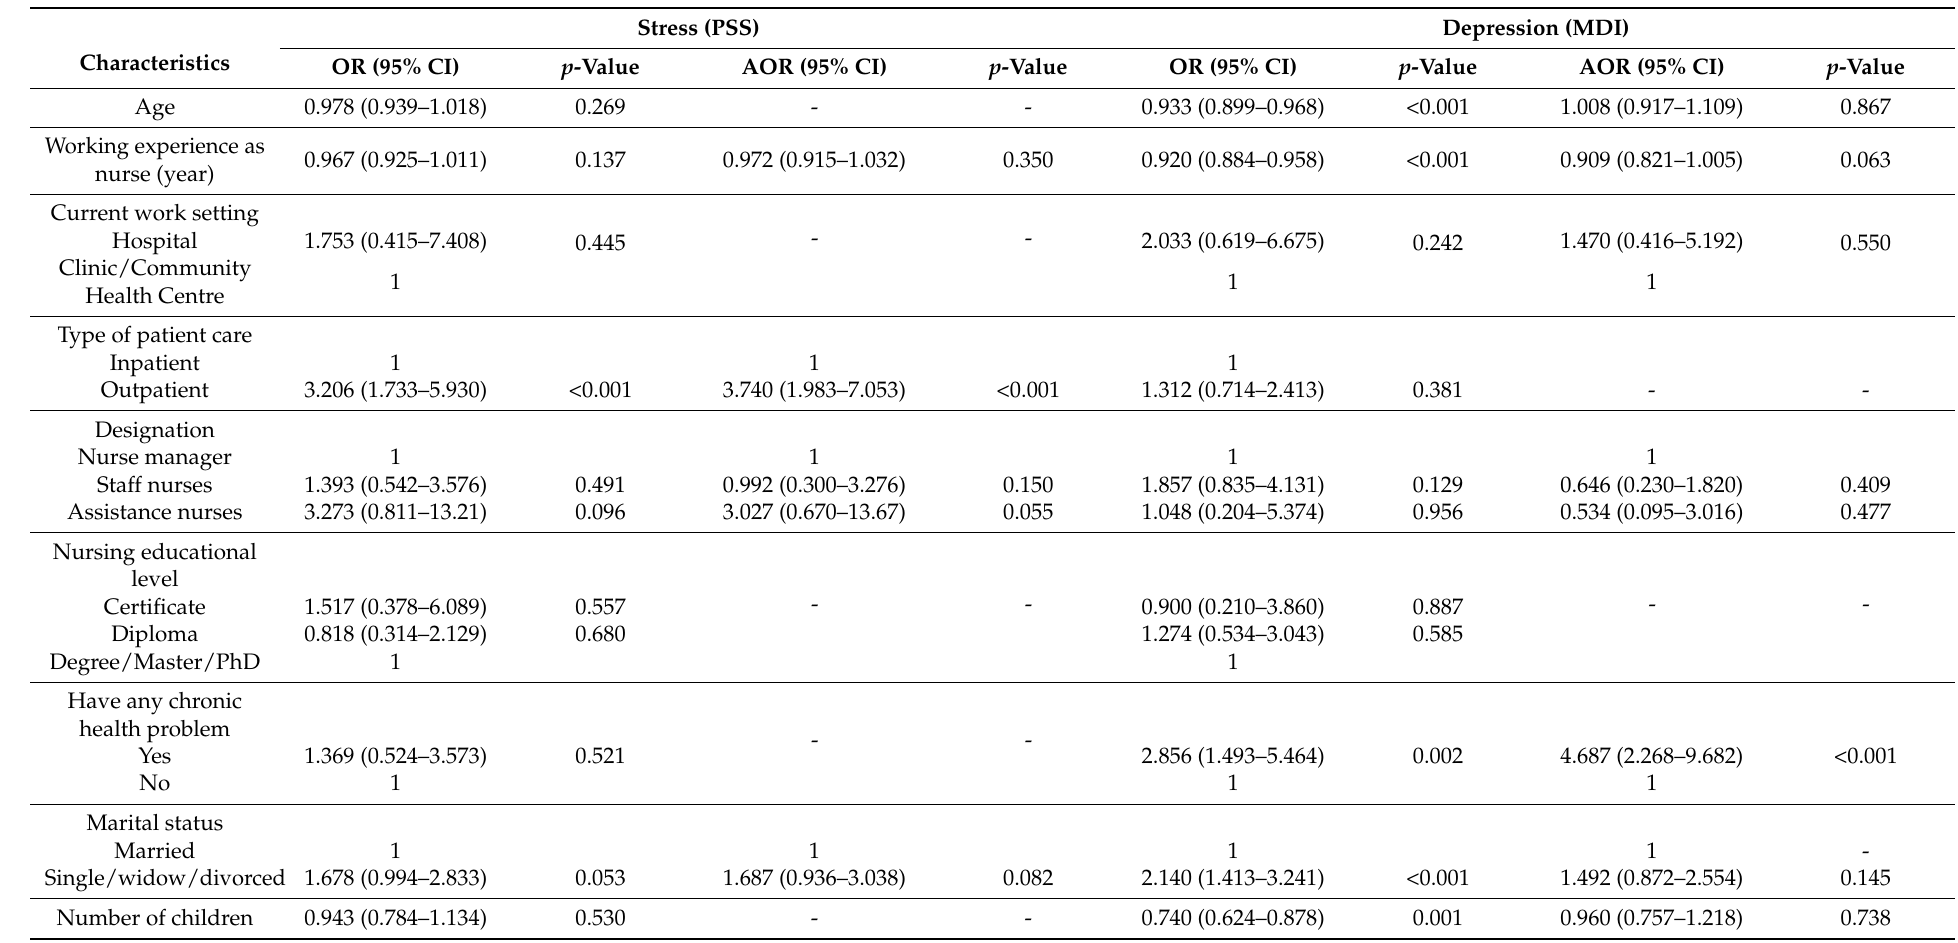
Table 5. Univariate and multivariate logistic regression on perceived stress and depression (N =